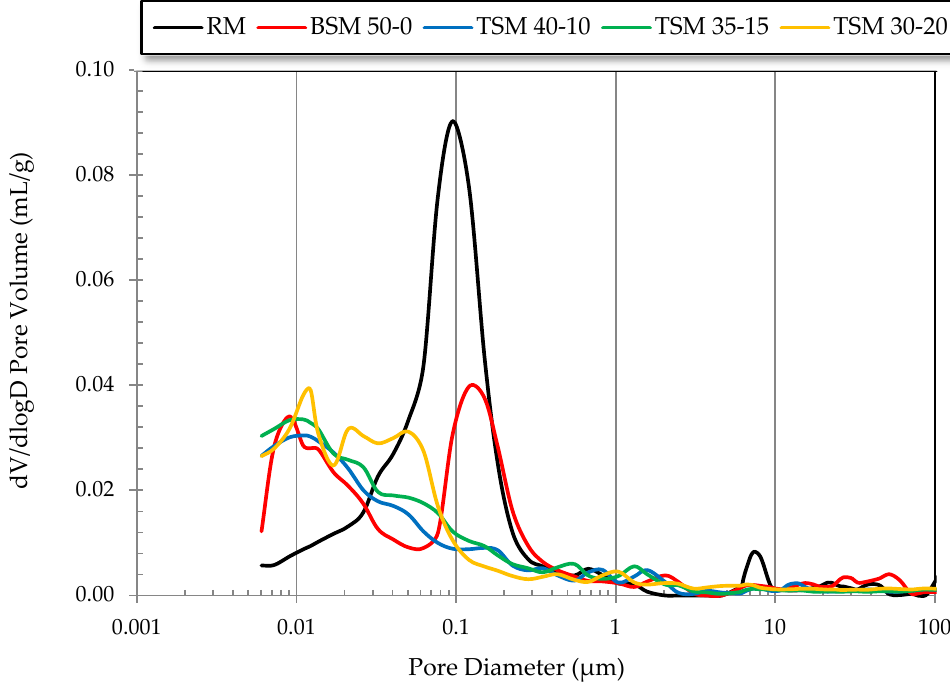
Figure 8. Pore distribution of RM, BSM 50-0, TSM 40-10, TSM 35-15, and TSM 30-20 mortars at 90 days.